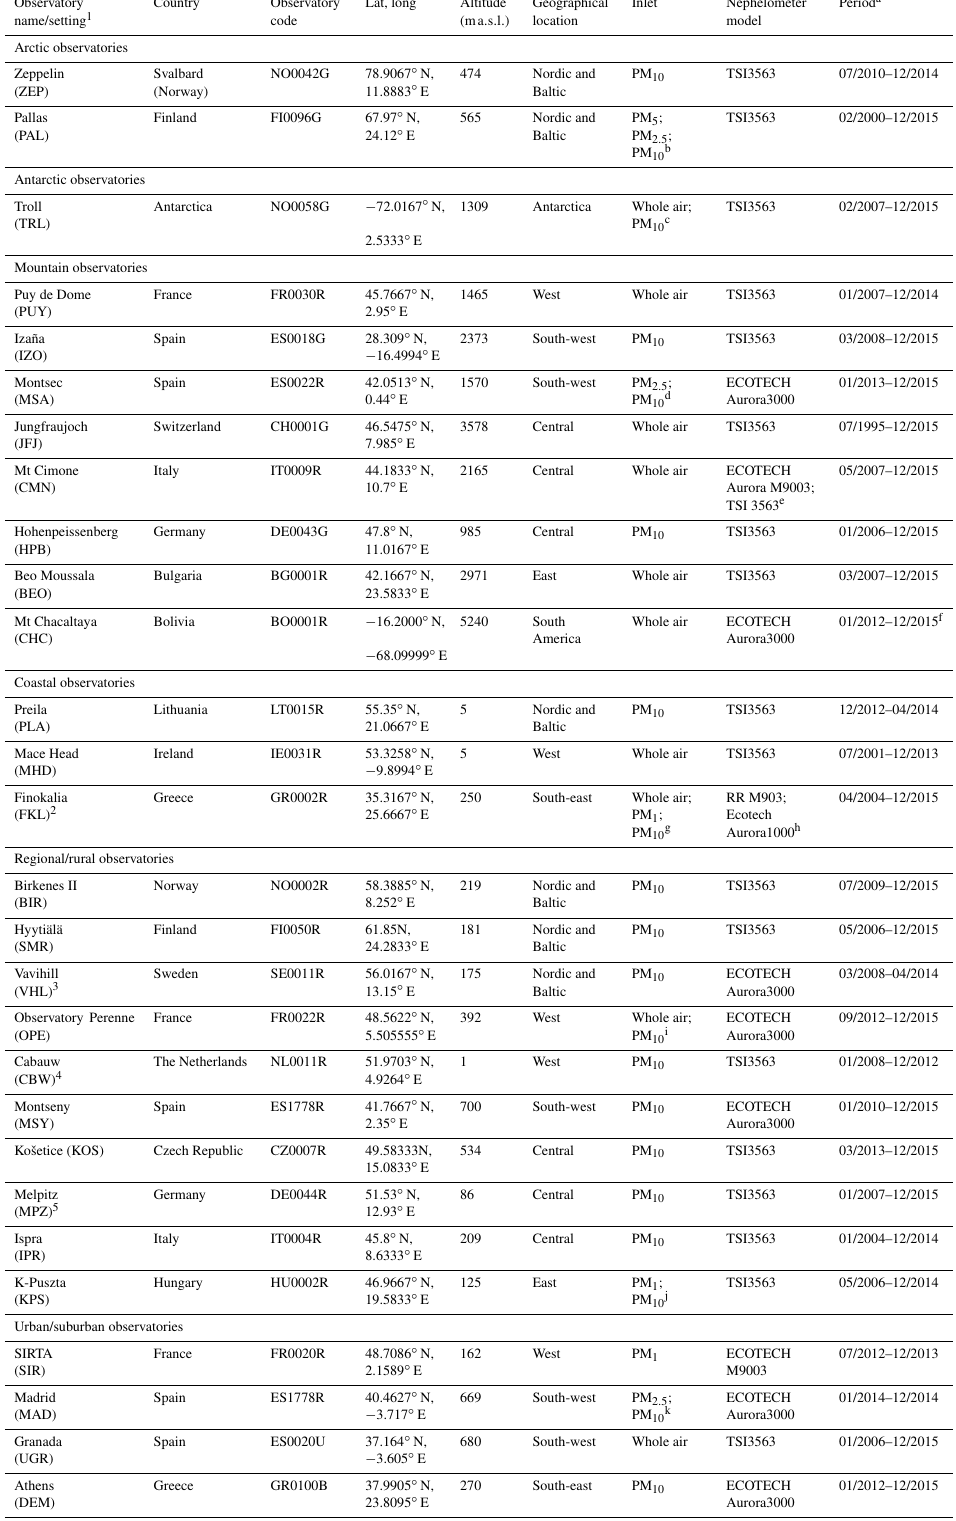
Table 1. List of ACTRIS observatories providing aerosol particle-scattering